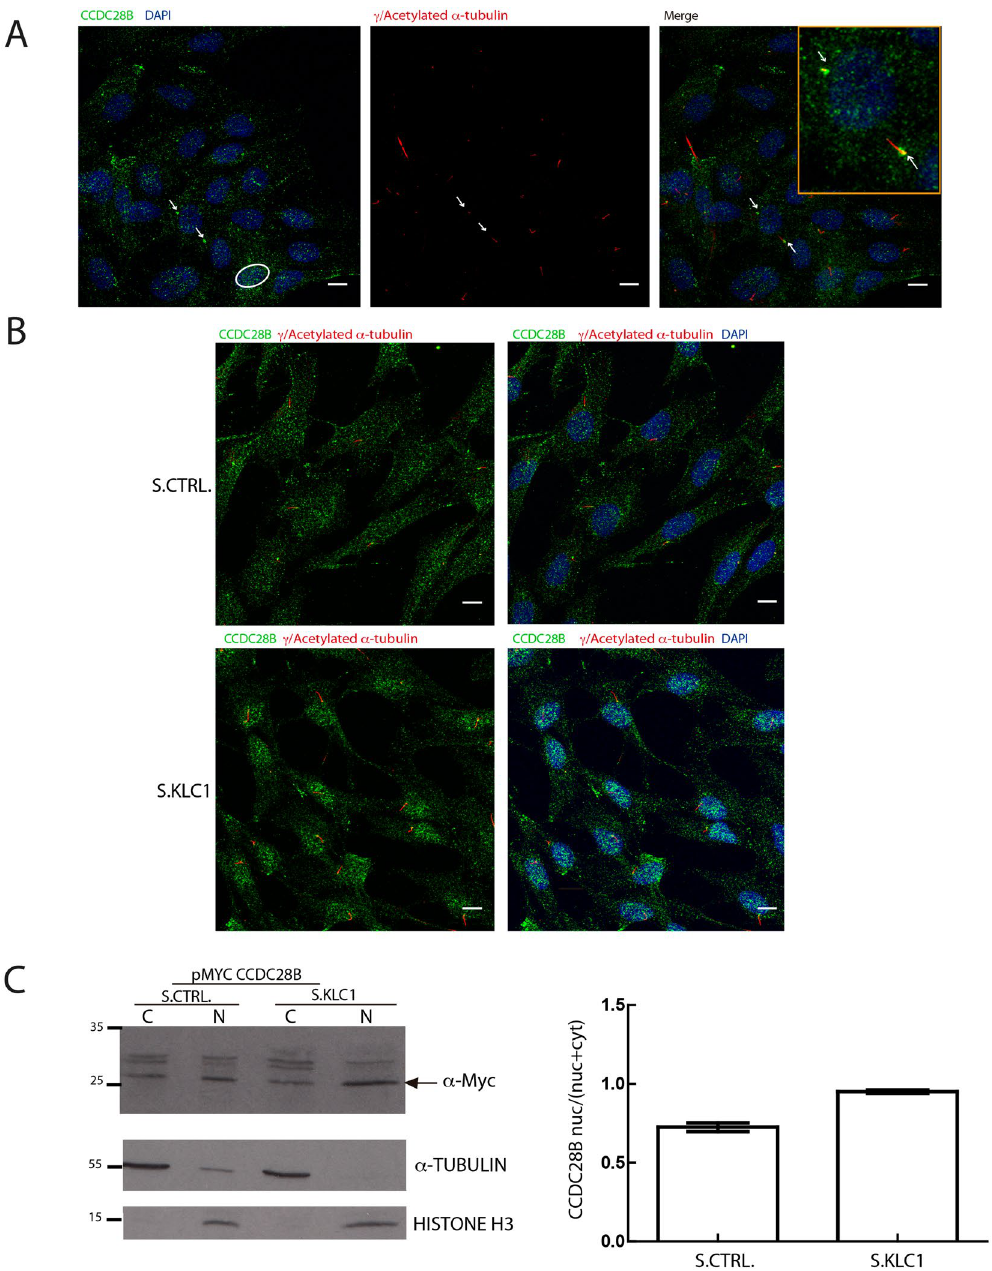
Figure 5. KLC1 plays a role regulating the sub-cellular distribution of CCDC28B. ( A ) Confocal microscopy analysis of endogenous CCDC28B (green) in hTERT-RPE cells showing localization of the protein in the cytoplasm, pericentriolar region/basal body (arrows illustrate examples in a ciliated and a non-ciliated cell, higher magnification in yellow box) and the nucleus (circle). Basal bodies and cilia axoneme were stained with anti- γ - and anti-acetylated α -tubulin respectively (red). ( B ) CCDC28B (green) signal is increased in the nucleus upon KLC1 KD (S.KLC1; lower panels) compared to control cells (S.CTRL; upper panels). In both ( A , B ), DAPI was used to stain nuclei. Scale bars correspond to 10 μ m. ( C ) Sub-cellular fractionation assay using hTERT-RPE cells transfected with a Myc-CCDC28B expressing plasmid together with stealth control (S.CTRL) or stealth KLC1 (S.KLC1). CCDC28B is present in both the cytosolic and nuclear fractions in control cells and accumulates in the nuclear fraction in KLC1 KD cells. The membrane was cut at the 35 KDa ladder band. The blot incubated with the α -Myc to visualize CCDC28B was stripped and probed with α -Histone. The graph shows the nuclear/total (nuclear + cytoplasmic) ratio obtained by quantifying the western blot bands by densitometry. α -tubulin was used to normalize the nuclear intensity of CCDC28B and compensate for the cytosolic contamination in the nuclear